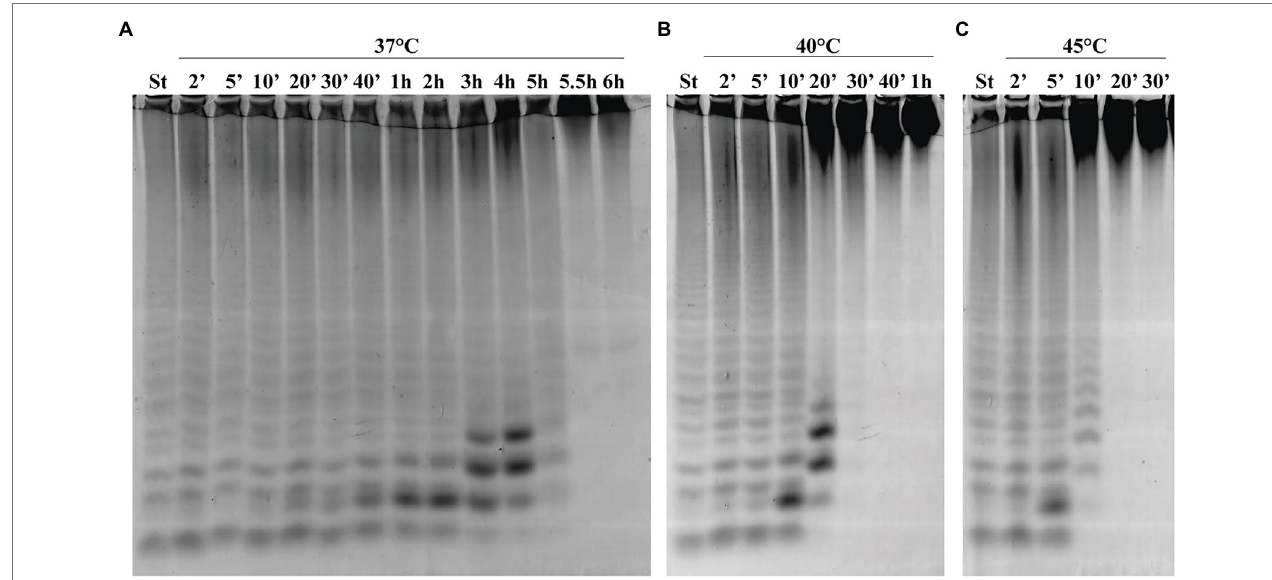
FIGURE 7 | Thermostability of Fhf2 ∆ 484. Fhf2 ∆ 484 was incubated without substrate for the indicated time periods, before the activity was determined on fucoidan from F. evanescens . (A) 37 ° C, (B) 40 ° C, and (C) 45 ° C. (St) positive control reaction of FFA2 on F. evanescens fucoidan. Reaction conditions: 0.9%